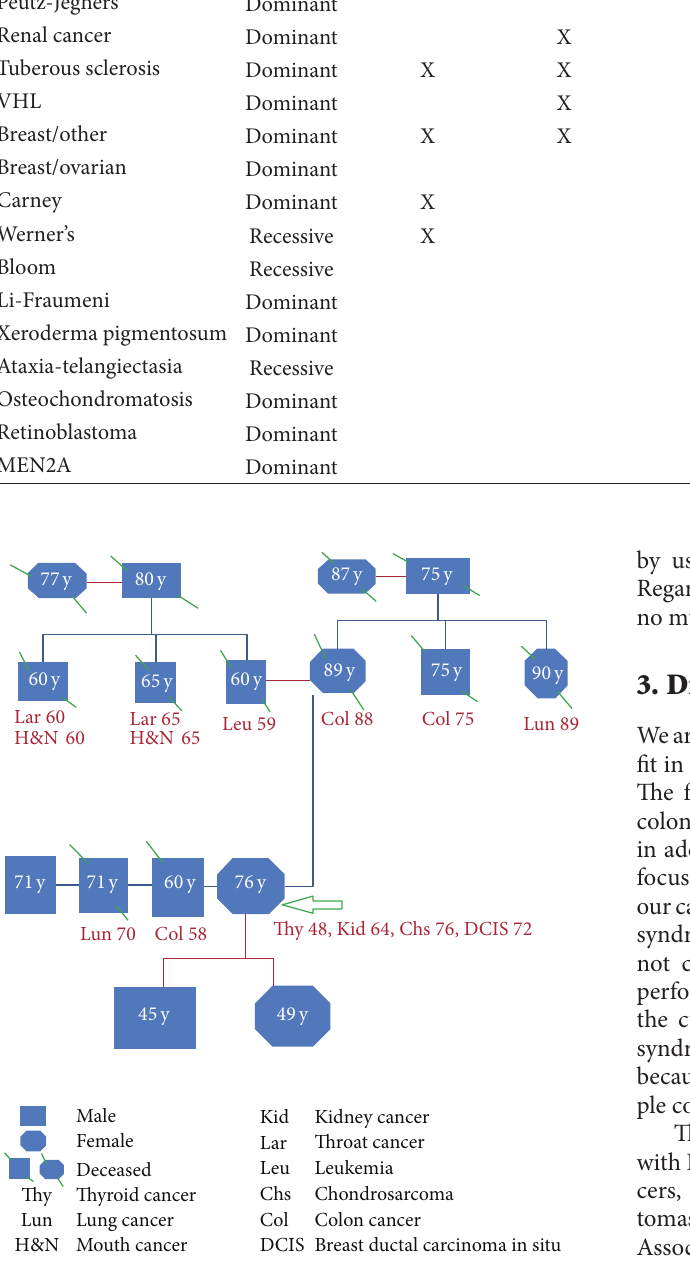
Figure 2: A family pedigree of the presenting case showing multi- ple cancers related to family members. The arrow refers to our pre- senting case with multiple cancers related to different body